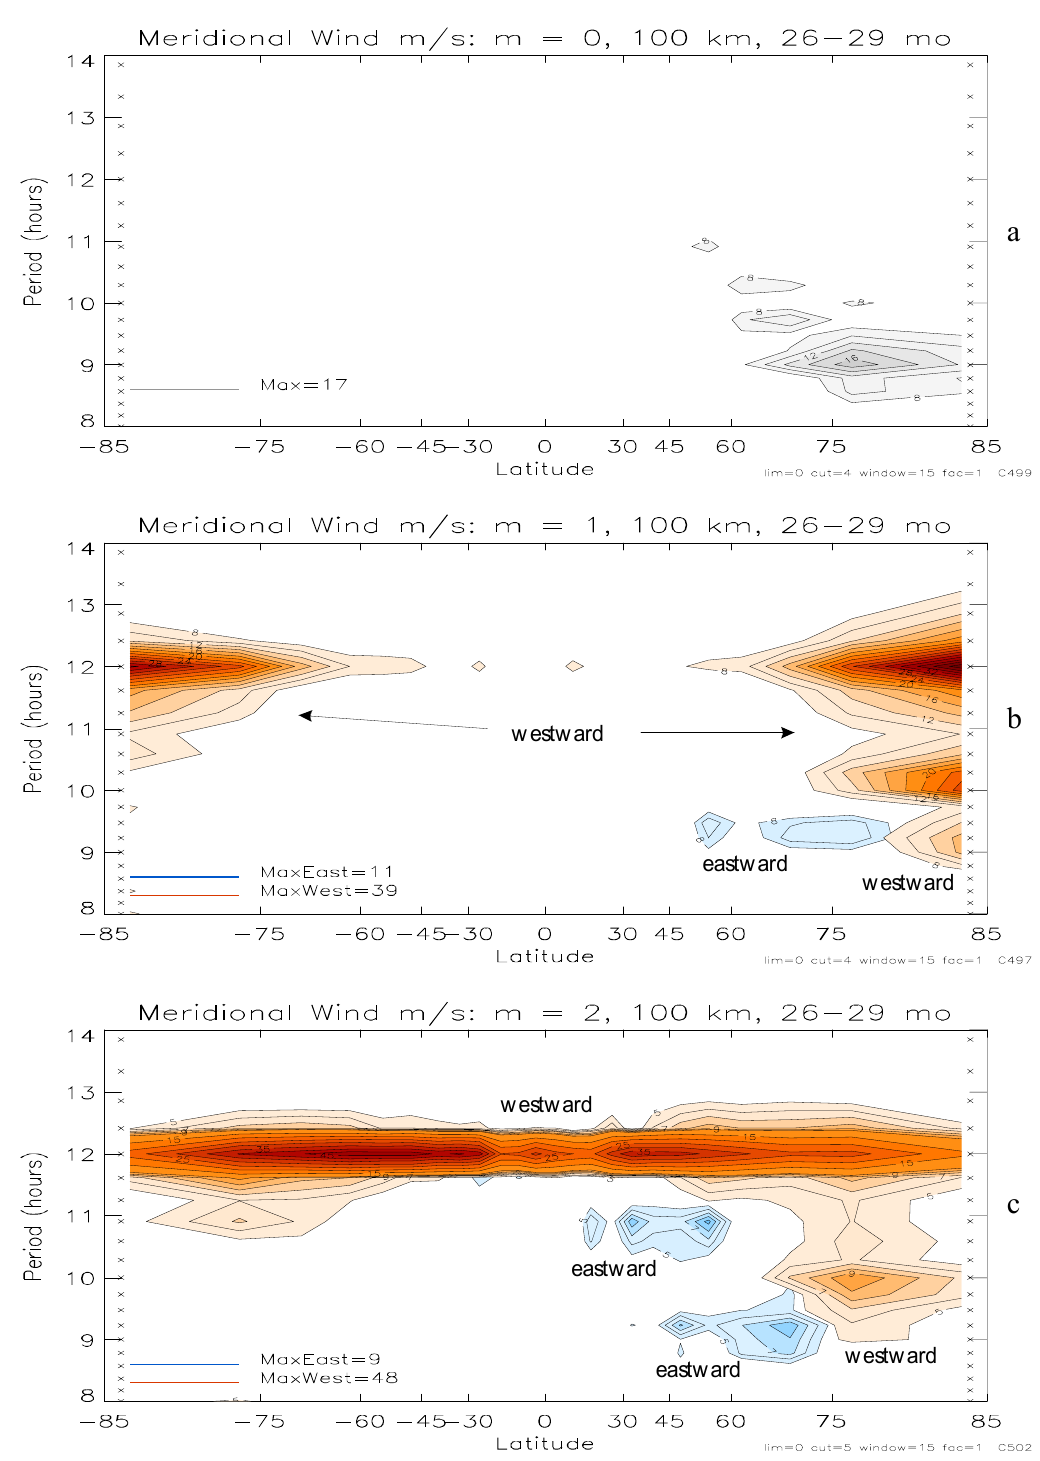
Fig. 5. Maximum amplitude spectra for zonal wave numbers m=0 ( a ) , m=1 ( b ) and m=2 ( c ) at 100km for periods between 8 and 14h, computed from the 26 to 29 months time span (March through May) with a running window of 15 days. The gray scale is used for m=0 (no propagation), red for westward, and blue for eastward propagation. In (b) and (c), the contour intervals are variable to describe the large migrating and non-migrating tides. To eliminate clutter, the lowest 40% or 50% of contours are suppressed. The largest amplitudes from the contours are stated in each panel. The x-marks on the vertical axes denote the discrete periods for which the maximum amplitudes are computed to produce the